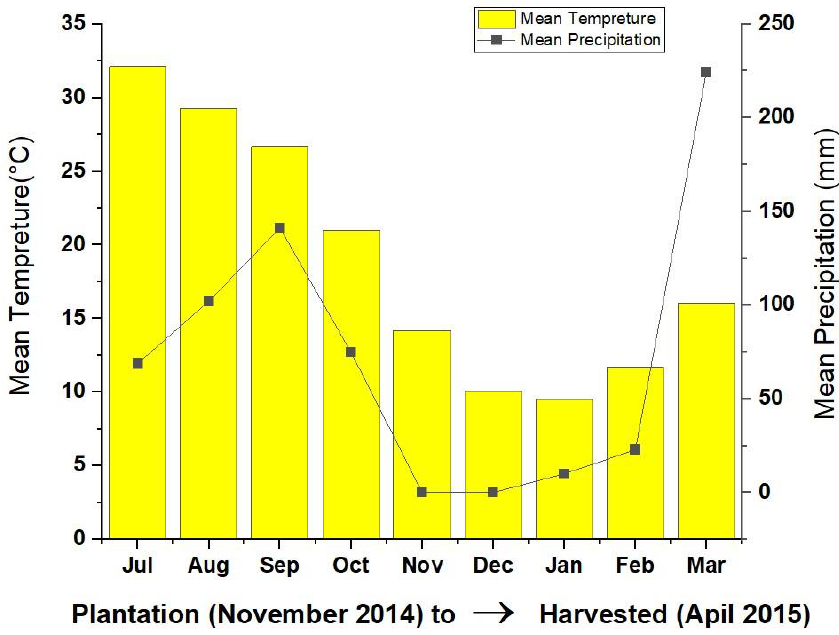
Figure 2. Mean temperature and precipitation of the study site.